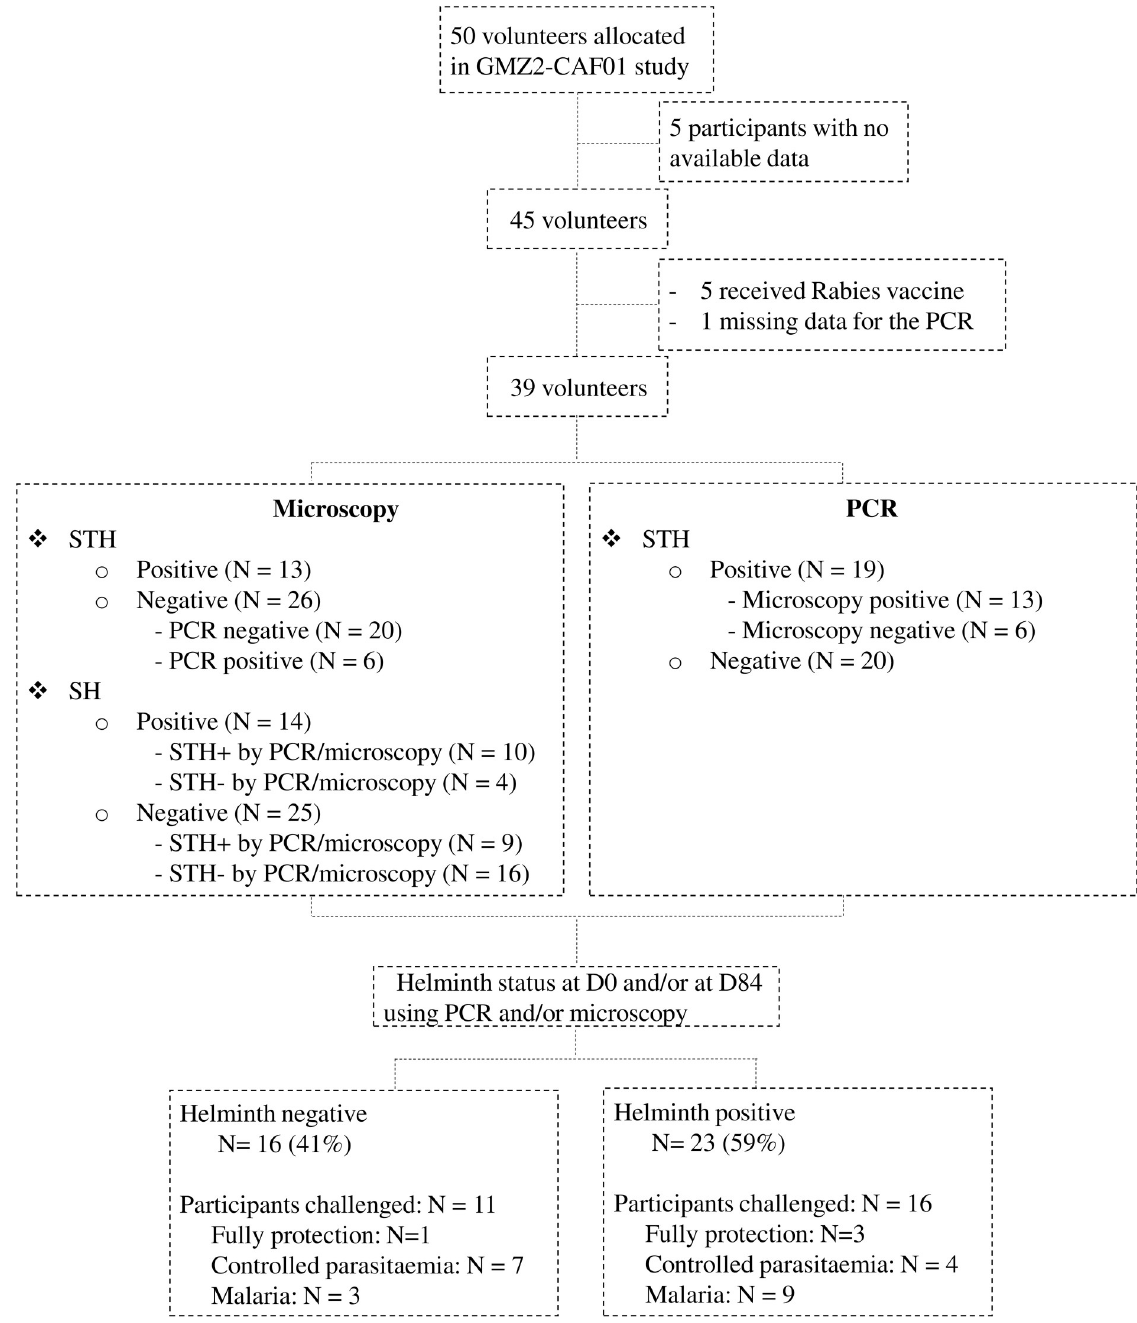
Fig 1. Flow chart of the study participants. PCR: Polymerase chain reaction STH: Soil-transmitted helminth SH: Schistosoma haematobium N = number